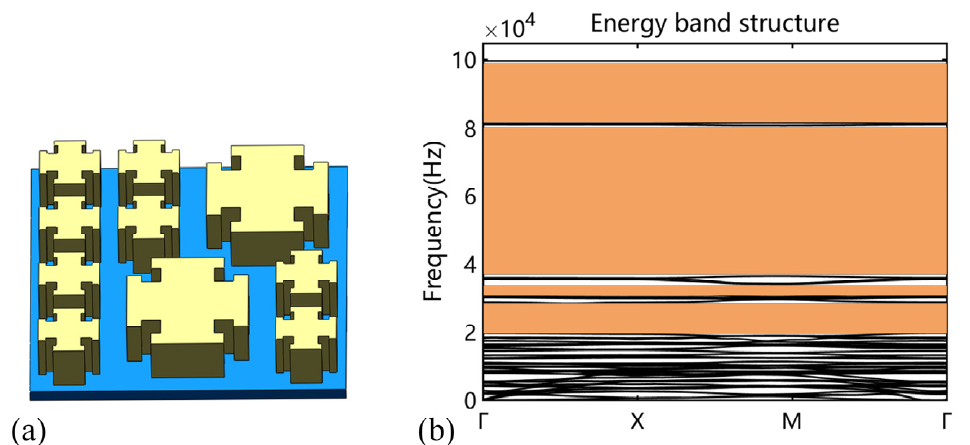
Figure 8. ( a ) The schematic diagram of the larger representative unit cell, including eight small blocks and two large ones; ( b ) the energy band structure of the larger representative unit cell.